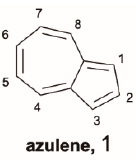
Figure 1. Polarized resonance structure of azulene with the dipole moment ( left ) and reactivity of each position of azulene ( right ). Adapted with permission from [33], Copyright 2021, American Chemical Society.